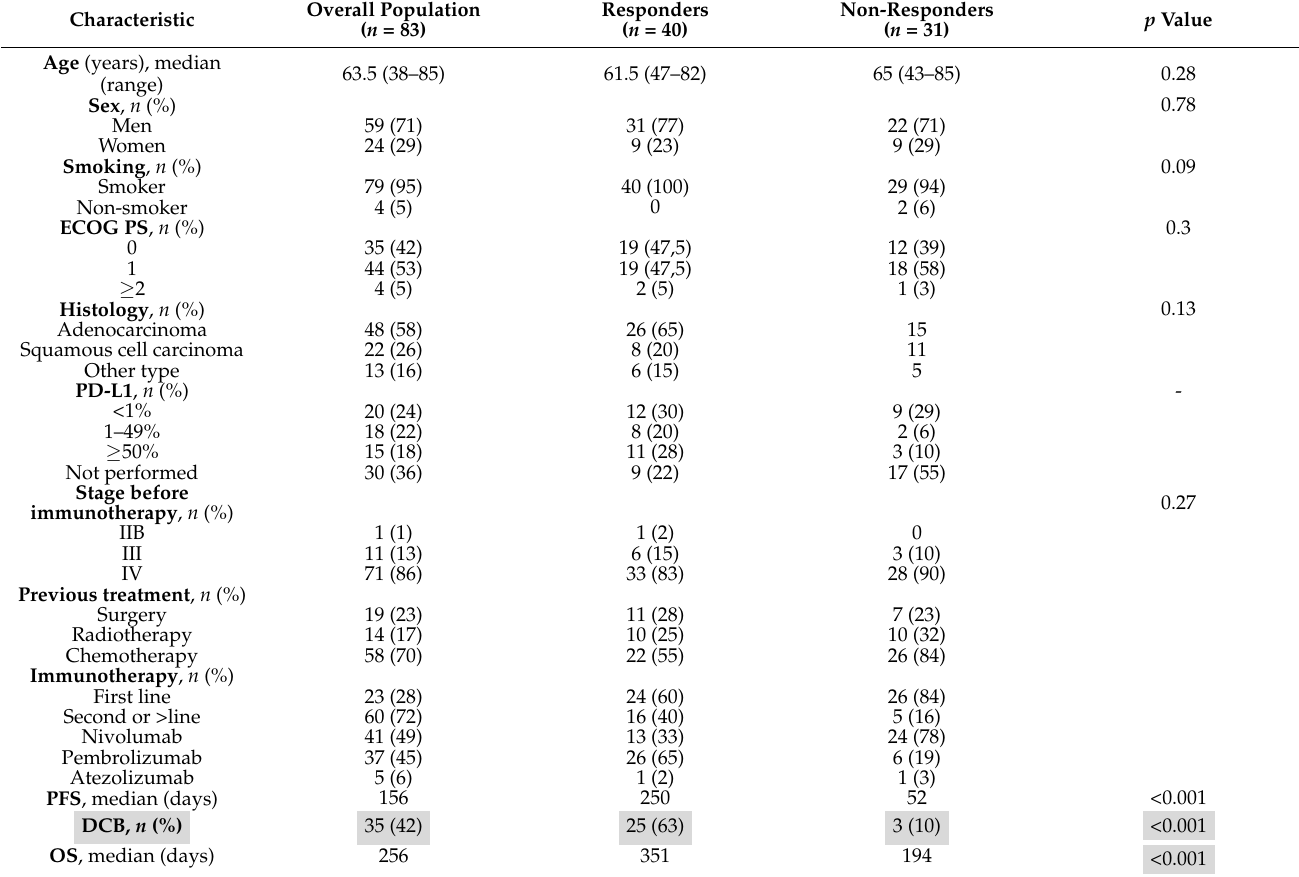
Table 1. Clinical and demographic characteristics of overall population (83 patients) and correlation of these parameters with iPERCIST response (evaluated in 71 patients) (chi-square and Mann–Whitney